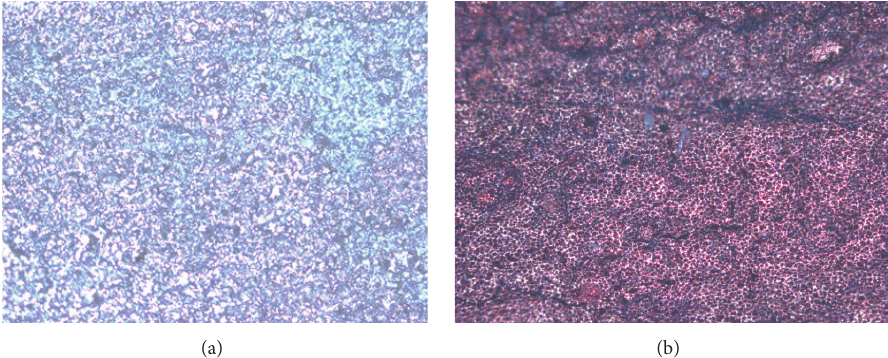
Figure 8: Optical microscope images (magnification × 5) of sintered silver ((a) Sample 4) and copper ((b) Sample 8) ink layers on wood substrate.